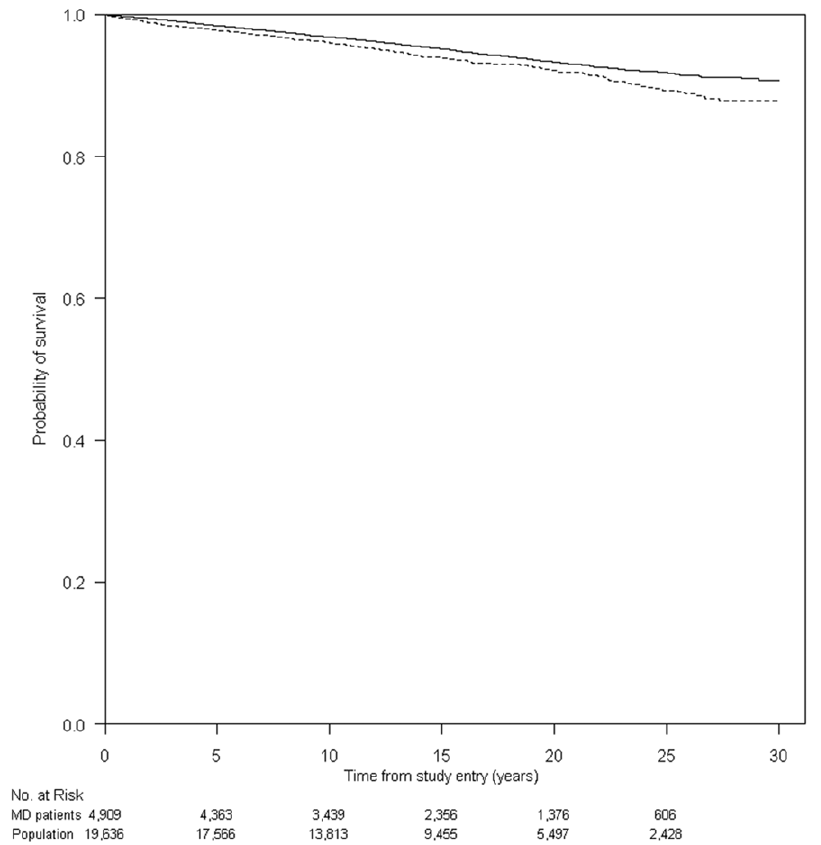
Figure 1. Kaplan-Meier survival curves of patients with meningococcal disease (MD) (dotted line) and individuals from the population cohort (full